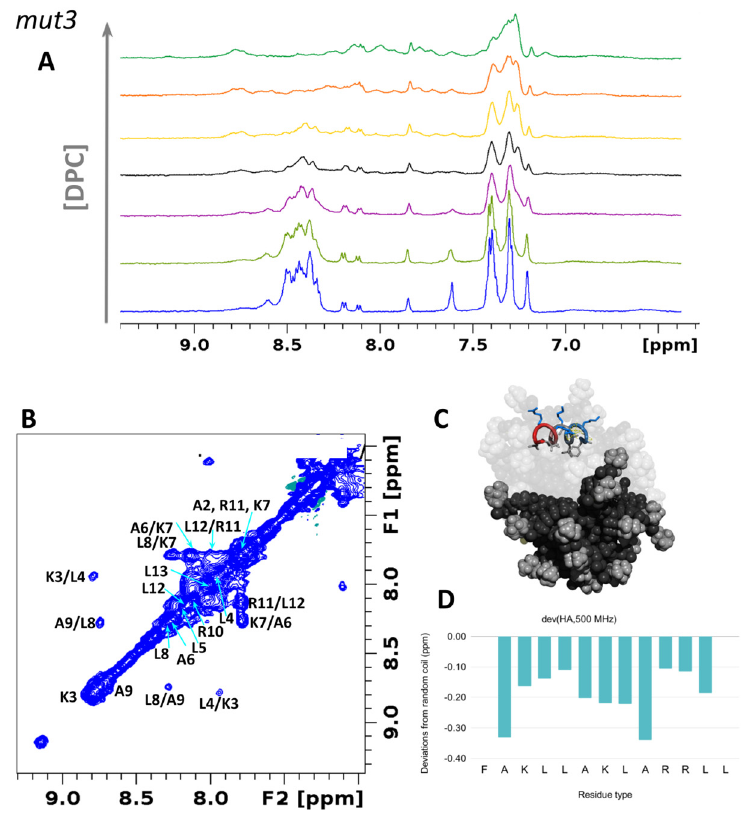
Figure 5. mut3 assumes alpha-helical conformation in a lipidic environment. ( A ) 1 H-NMR spectra of mut3 0.8 mM in the presence of DPC at concentrations of 2, 4, 8, 12, 24, and 50 mM. ( B ) 1 H, 1 H-NOESY spectrum of mut3 at 278 K in the presence of DPC micelles showing meaningful NOEs in the amide region. ( C ) MD snapshot of mut3 interacting with DPC micelles. The image was created with PyMol [76]. ( D ) Chemical shift deviations from random coil values of H α hydrogen atoms. Data on HB43 peptide were previously published